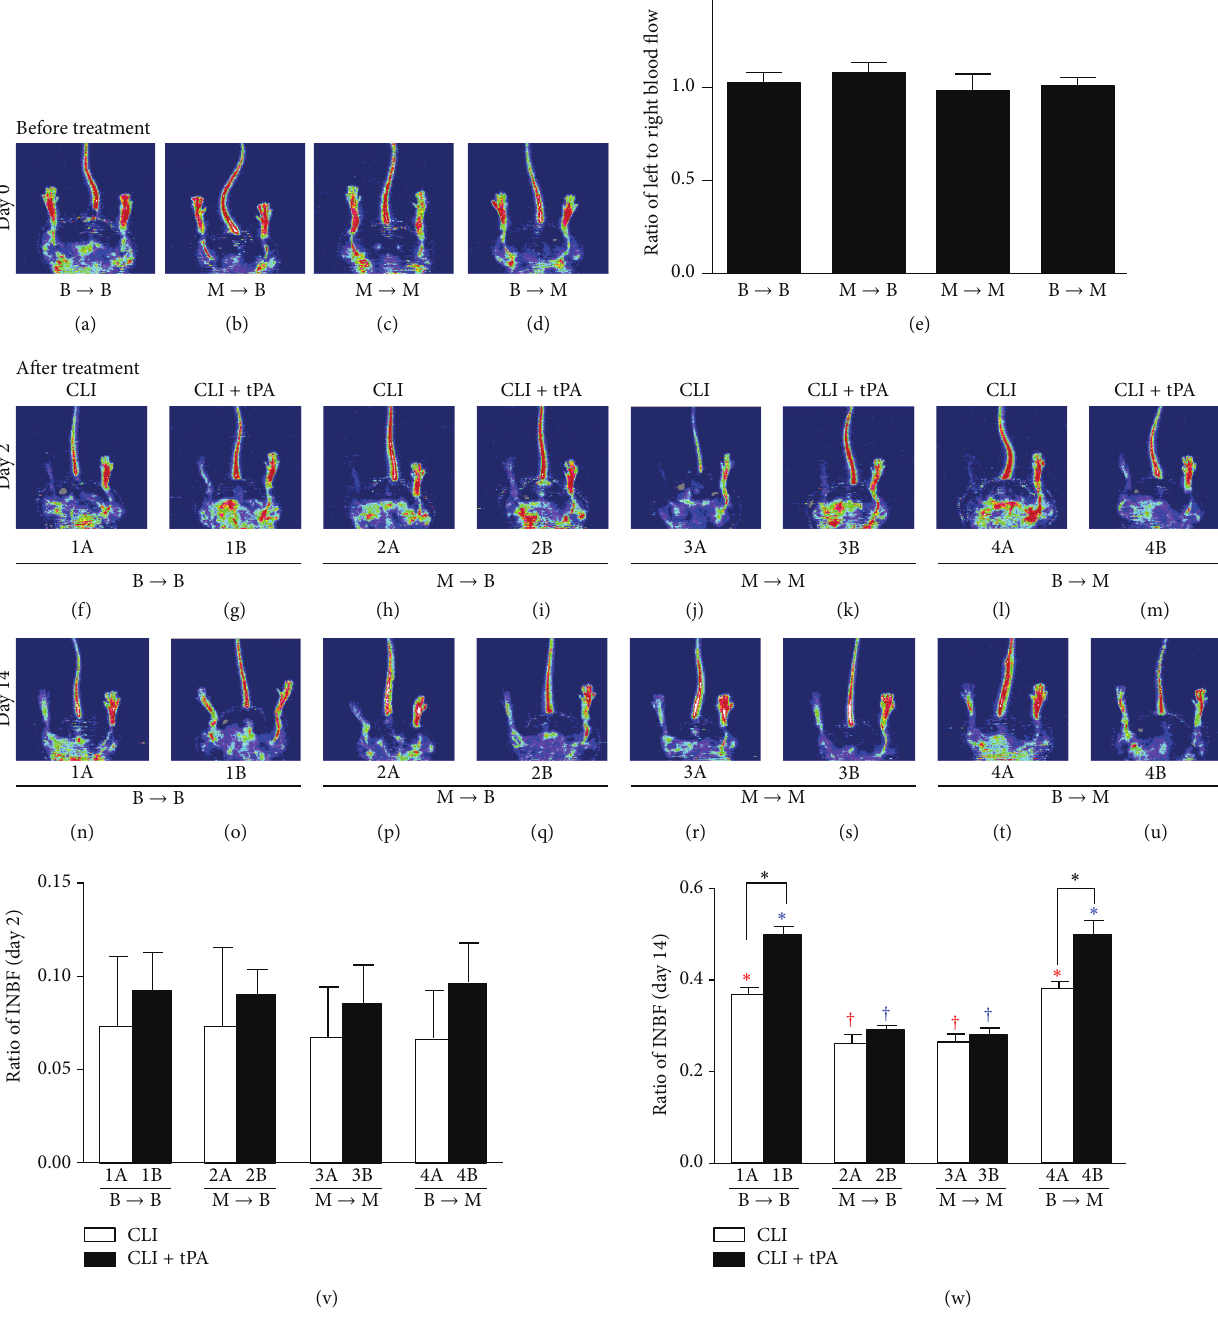
Figure 4: Serial changes of Laser Doppler scanning of hind limb blood flow prior to and after critical limb ischemia (CLI) induction. (a–d) The normal blood flow in both hind limbs in each group prior to the CLI procedure. (e) Ratio of left (ischemia) to right (normal) blood flow, 𝑝 = 1.0 . (f–u) The blood flow in left and right hind limbs under the treatment conditions of CLI and CLI + tPA in 4 groups (i.e., B → B, M → B, M → M, and B → M) at day 2 or day 14 after the procedure. (v) Quantitation and calculation of ratio of ischemia to normal blood flow (INBF) among the four groups at day 2. (w) Quantitation and calculation of ratio of INBF among the four groups at day 14. Statistical analysis for individual group at different treatment conditions. (1) In B → B, 1A versus 1B, ∗ indicates 𝑝 < 0.01 . (2) In M → B, 2A versus 2B, 𝑝 > 0.5 . (3) In M → M, 3A versus 3B, 𝑝 > 0.5 . (4) In B → M, 4A versus 4B, ∗ indicates 𝑝 < 0.01 . (2) Statistical analysis for group comparison with respective treatment condition. (1) For CLI subgroup (white bar chart), groups with different red symbols ( ∗ , † ), 𝑝 < 0.01 . (2) For CLI + tPA subgroup (black bar chart), groups with different blue symbols ( ∗ , † ), 𝑝 < 0.01 . SC = sham control; tPA = tissue plasminogen activator. 𝑛 = 6 for each